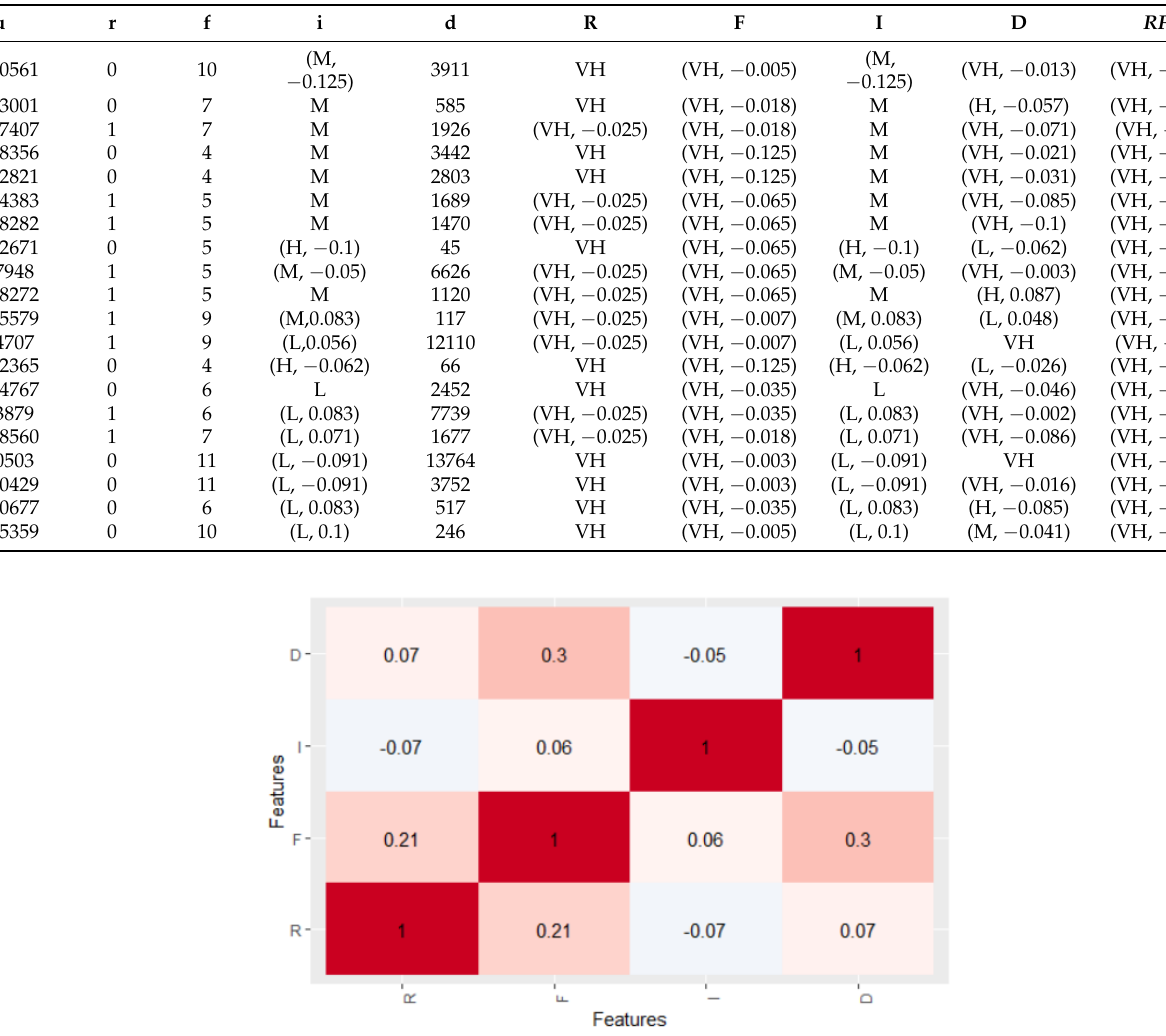
Table 9. RFID Overall Score for Some Customers.